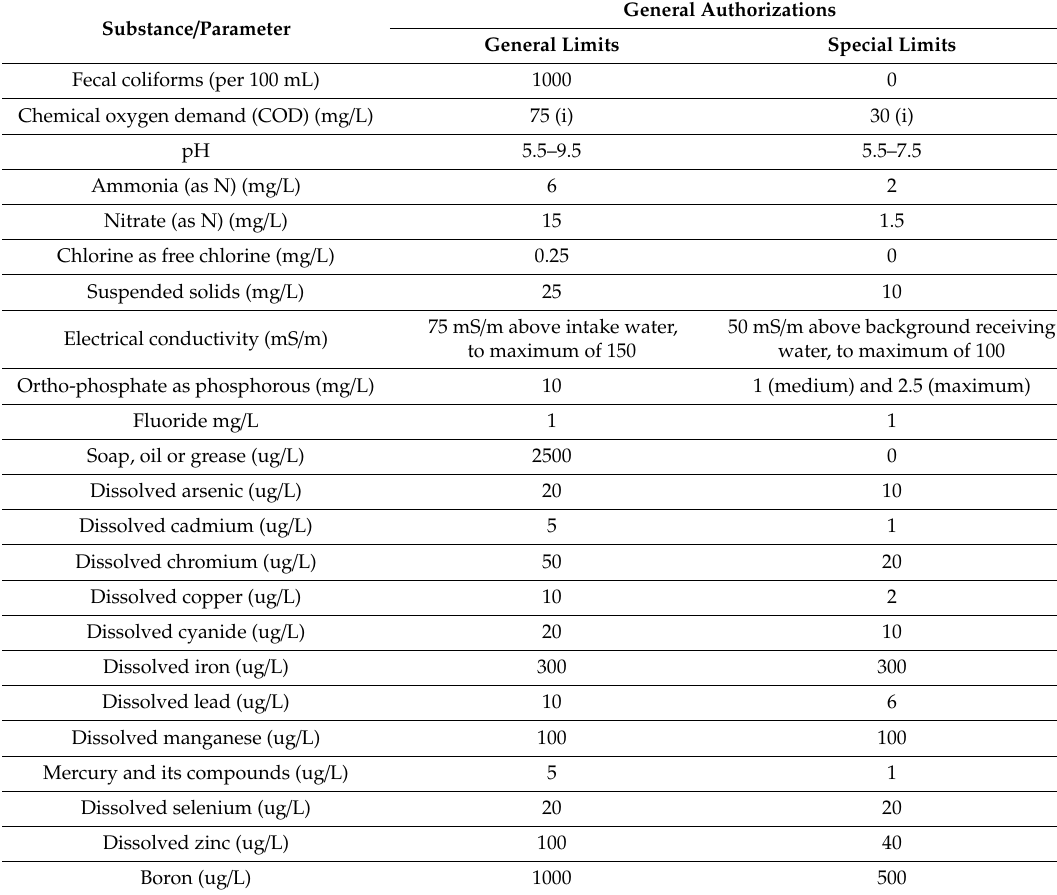
Table 1. South African General Authorizations for general and special limits